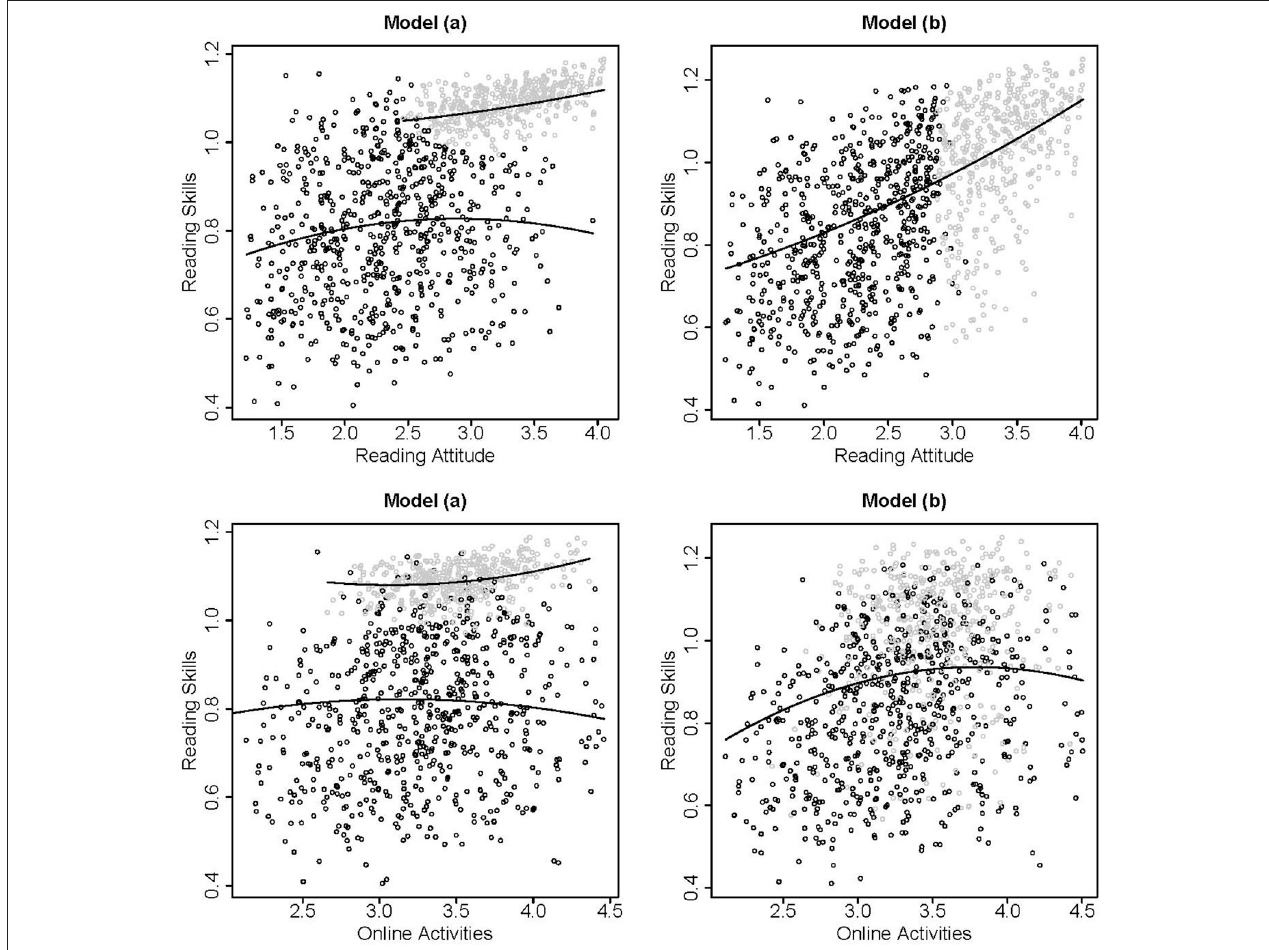
FIGURE 1 | Scatter plots of the estimated factor scores based on the two class solutions of Model (a) (left panels) and Model (b) (right panels) for reading attitude and reading skills (upper panels) and online activities and reading skills (lower panels). The model based relationships between the variables are indicated with solid lines, class membership is indicated by black or gray